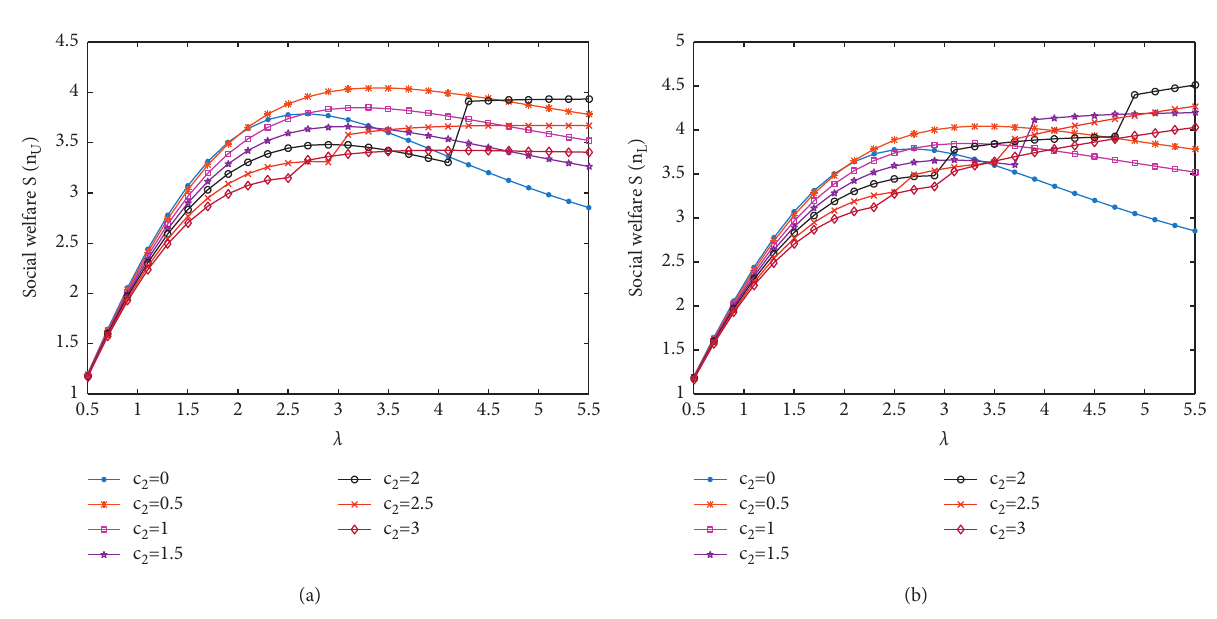
Figure 4: The social welfare S ( n